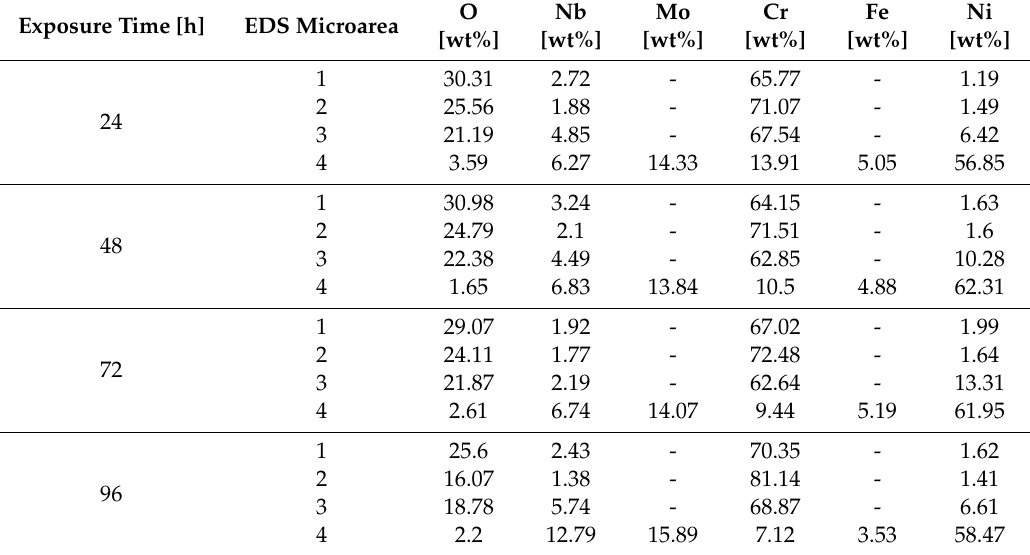
Table 3. Chemical composition evolution in the studied four microareas (oxidation at 1050 °C). Exposure Time [h]